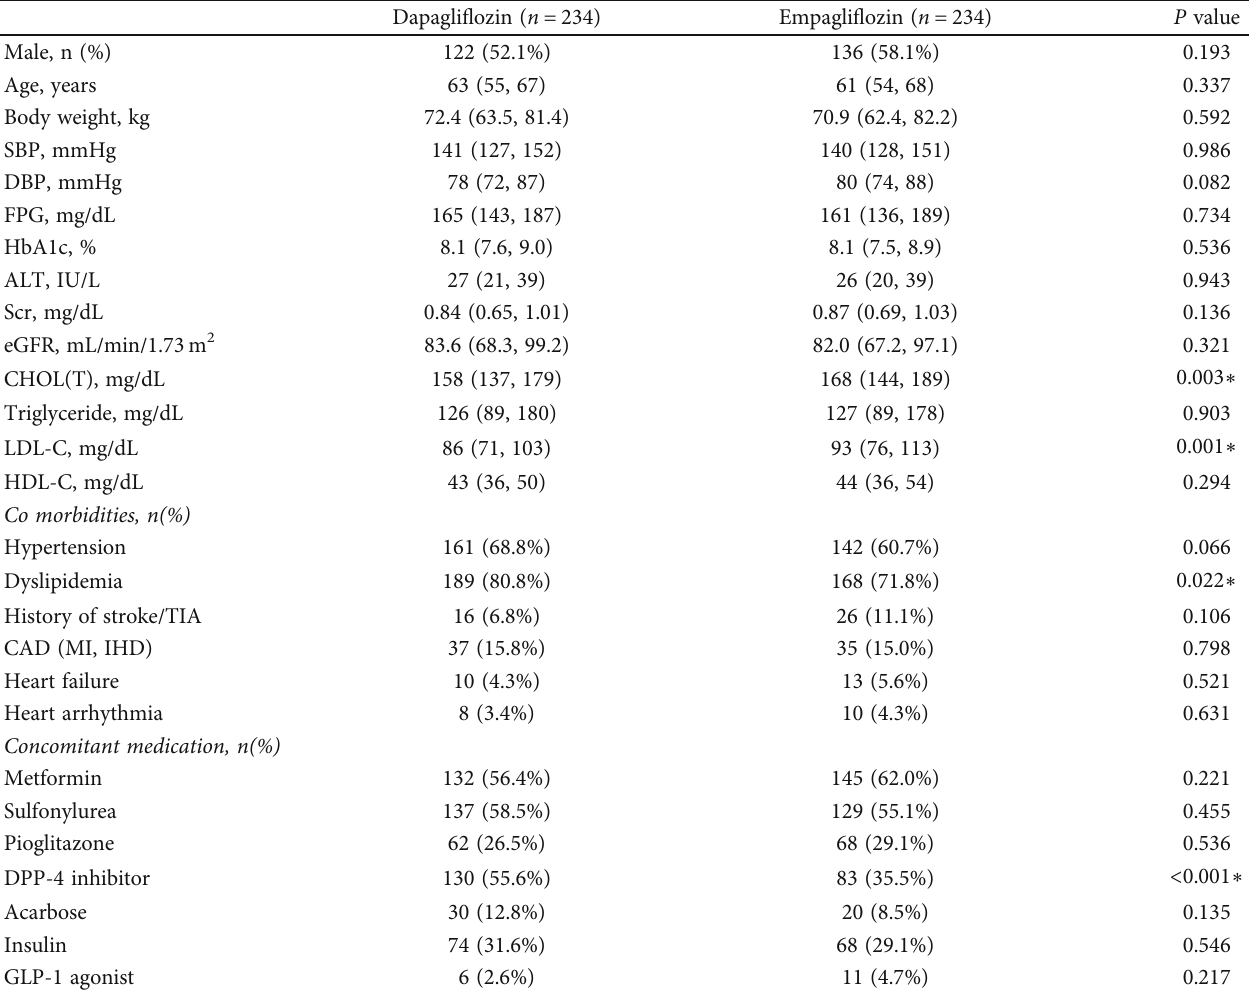
Table 1: Baseline demographics and clinical parameters of study